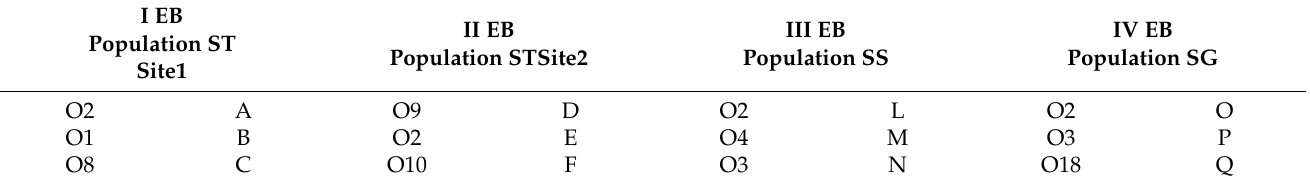
Table 1. D. obscura Cyt b haplotypes used in the experiment (left) and their corresponding IFL names (right) per experimental block. ST, Tara Mountain; SS, Balkan Mountains; SG, Go č Mountain.